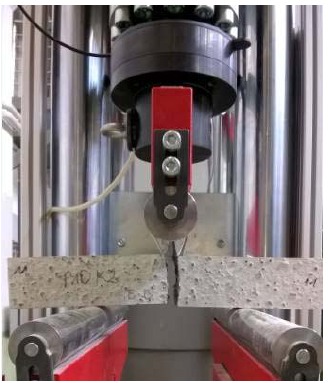
Figure 2. Flexural tensile strength test of C5P1b concrete.